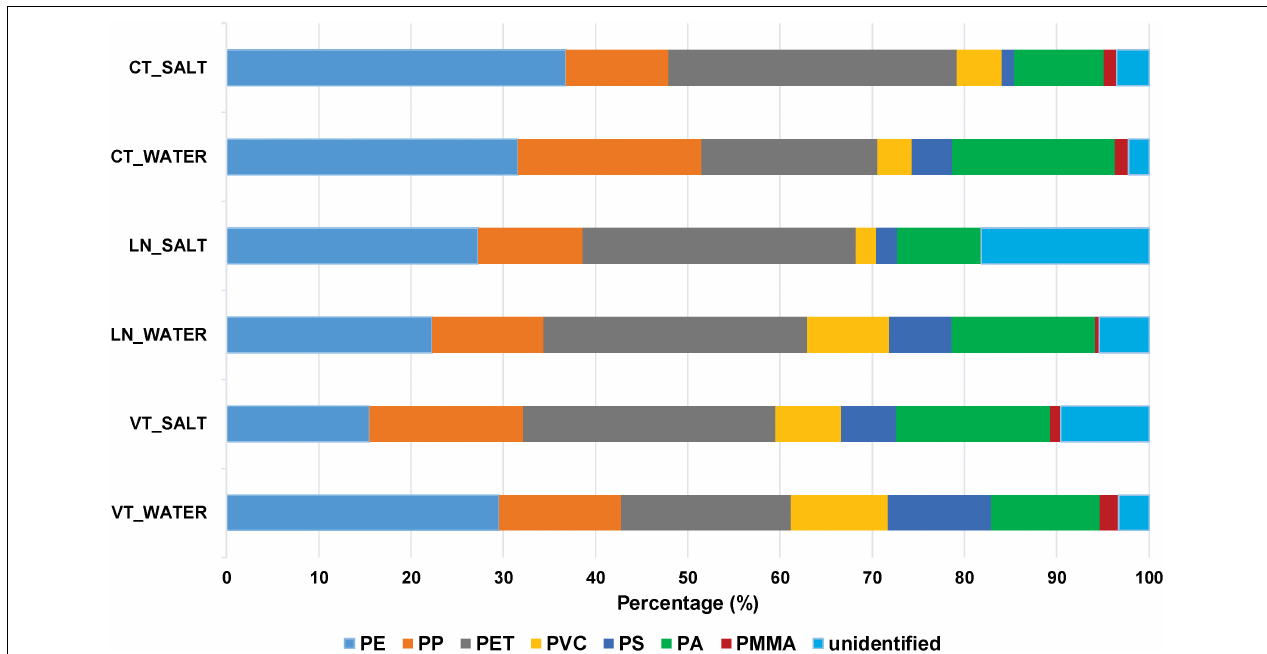
FIGURE 4 | Compositions of microplastics in seawater and its coarse salts collected in Vung Tau, Ly Nhon, and Can Thanh salt fields.